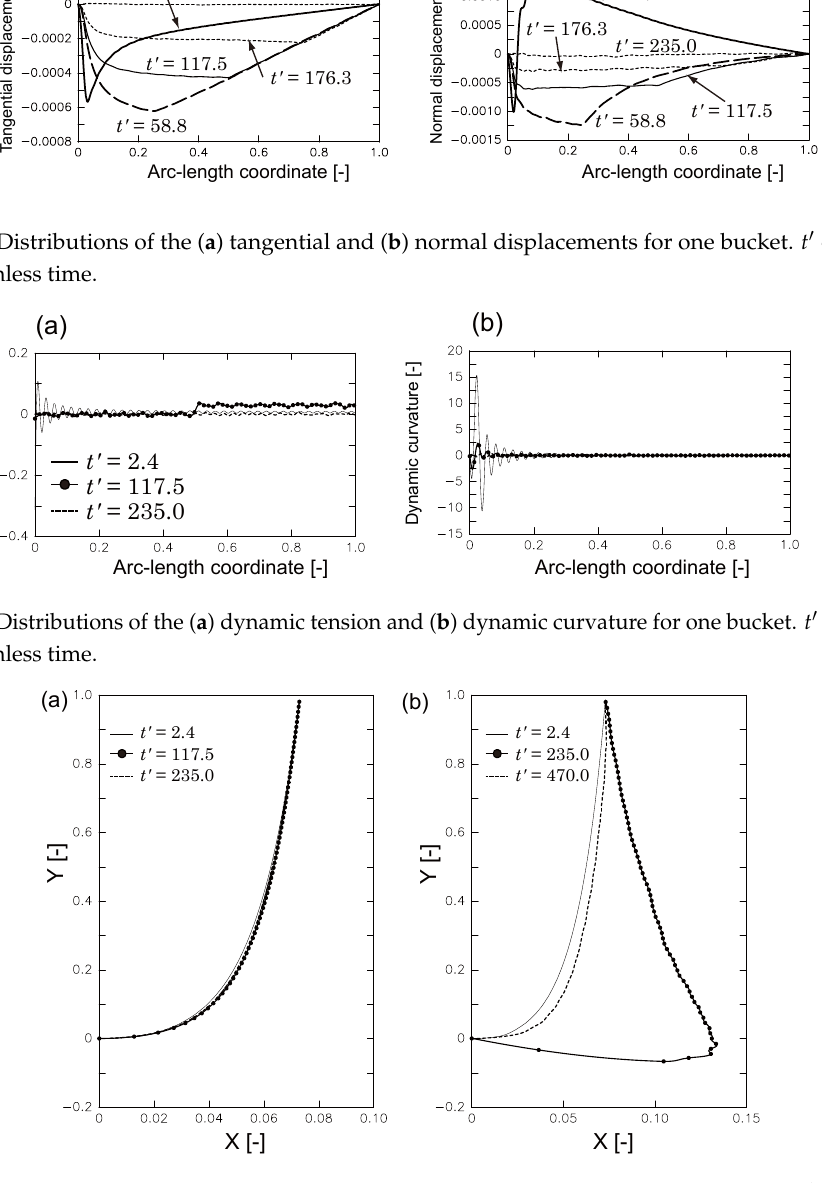
Figure 9. Cable configurations in the X–Y plane for ( a ) one bucket, and ( b ) 250 buckets. t (cid:48) denotes dimensionless